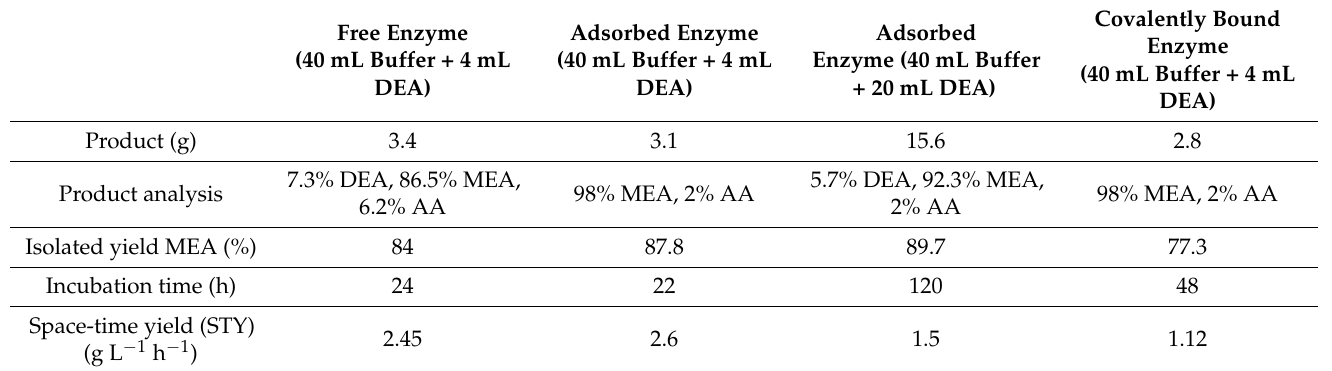
Table 4. Isolated product from up-scaled DEA hydrolysis reactions by ACut2-6hp